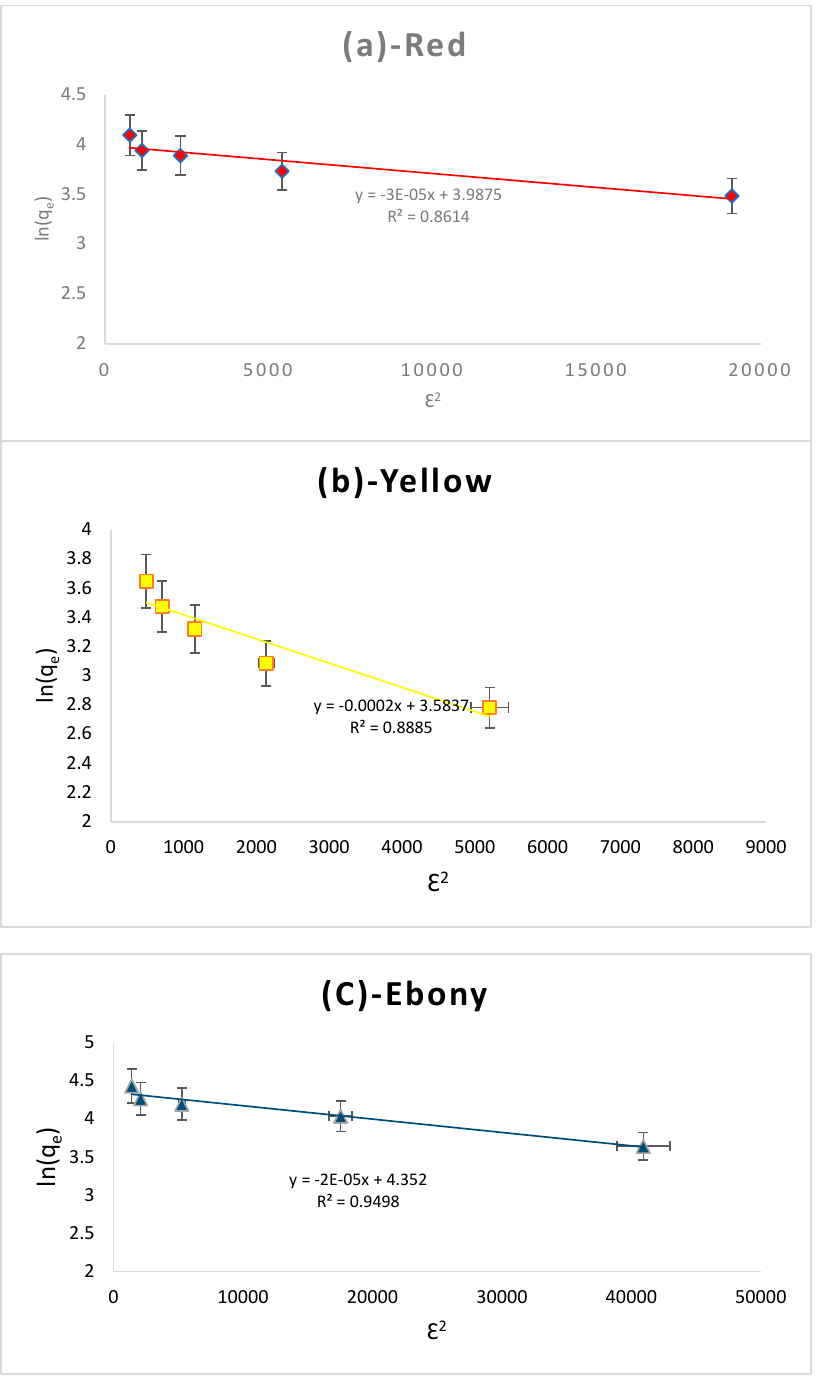
Figure 16. D-R isotherm of ( a ) R, ( b ) Y, and ( c ) E hair dyes onto COZ. The values of Temkin constant B (Table 3) reveal that the adsorption of hair dyes onto COZ adsorbent is endothermic. The plot demonstrated the endothermic nature of the adsorption process. Interestingly, a robust interaction between the hair dyes (R, Y, and